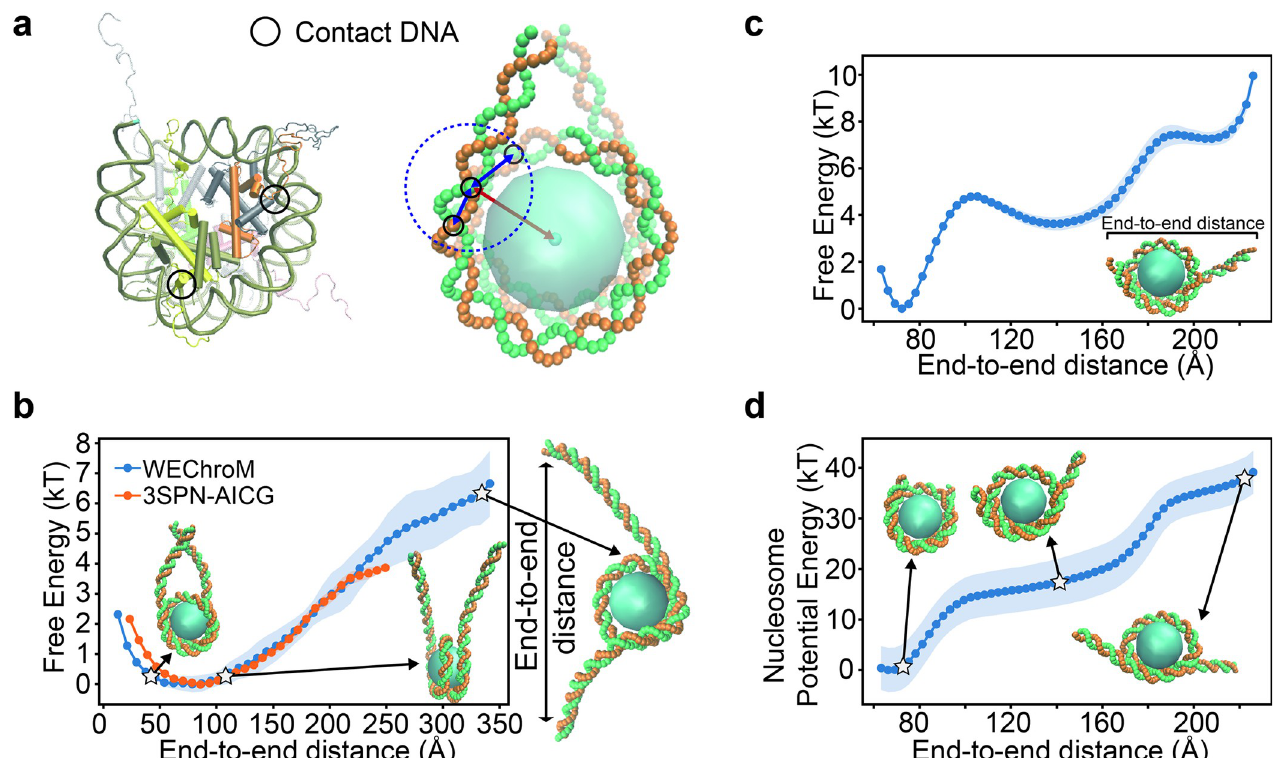
Fig 4. Nucleosome model and unwrapping analysis. (a) A detailed representation of the nucleosome core particle (PDB ID: 1KX5 [59]) (left) and the corresponding coarse-grained WEChroM representation (right). In the left figure, the upper half of the nucleosome particle is shown as solid while the lower half is transparent for clear visualization. The DNA nucleotides in close contact with amino acids are defined as “contact DNA” and subject to the AMH , potential modeling histones-to-DNA interactions (black circle). In our model, contact DNA interacts with the histone octamer’s center of mass ( U center represented by the red arrow in the figure). Contact DNA also interacts with neighboring contact DNA ( U , represented by the black arrows inside the neighbor indigo dashed circle). (b) Free energy of partial DNA unwrapping for a system composed of the histone octamer plus 223-bp of DNA; WEChroM model (blue) and 3SPN-AICG model (orange). Simulation data shown for the 3SPN-AICG mode are extracted from ref. [38], figure 8. Examples of nucleosome configurations are shown for end-to-end distances of roughly 45 Å (left), 107 Å (right), 330 Å (outside) (c) Free energy of partial nucleosome unwrapping for a system composed of the histone octamer plus 147-bp of DNA; WEChroM model. (d) Nucleosome AMH energy of the partial nucleosome unwrapping for the 147-bp WEChroM model. Example nucleosome configurations are shown for end-to-end distances of 76 Å (left), 142 Å (middle), 221 Å